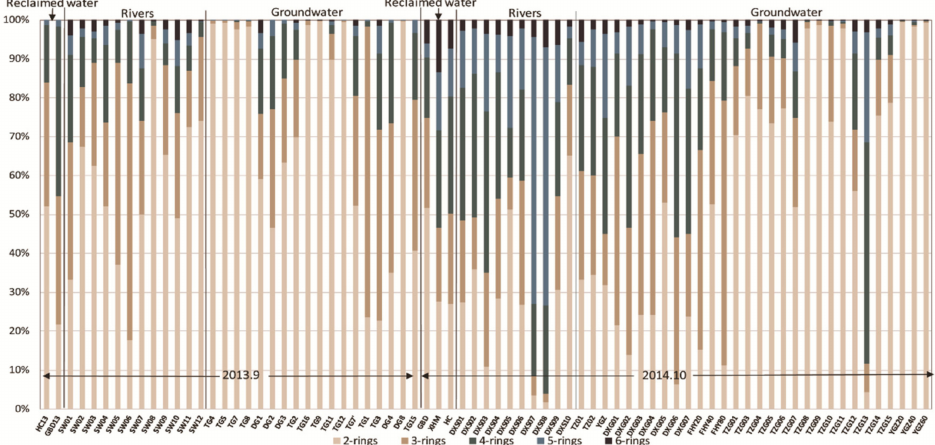
(cid:80) 16PAHs in reclaimed water, surface water and groundwater in